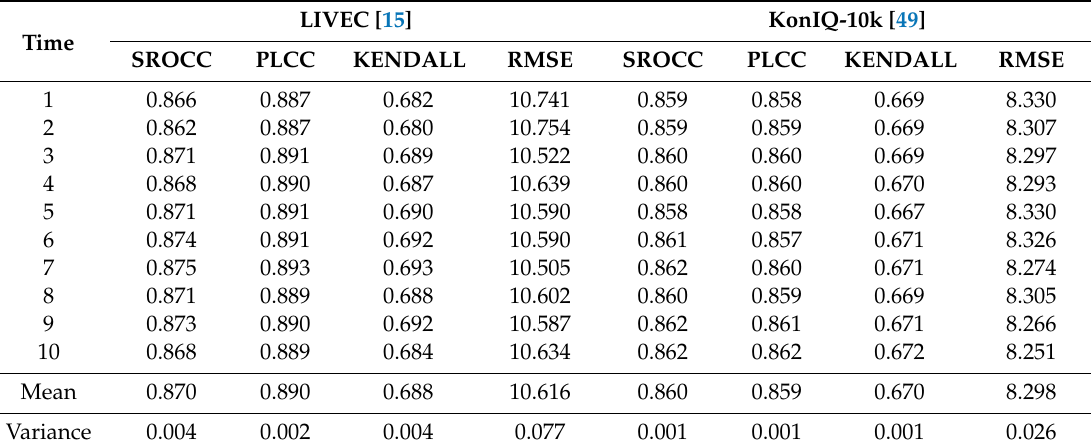
Table 6. Detailed data for 10 tests based on the Base + FT model.